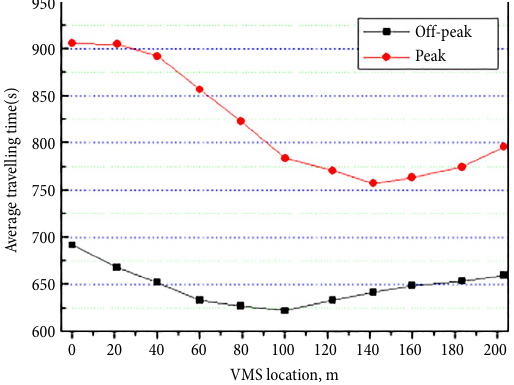
Fig. 8. Average travel time with VMS in different